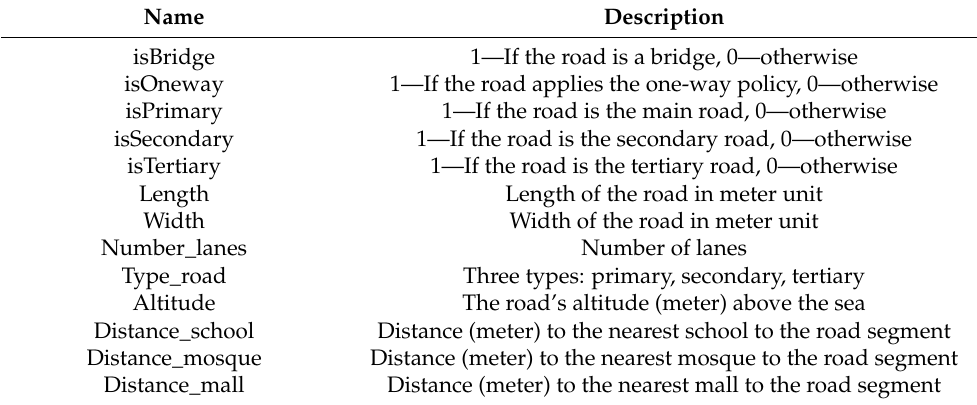
Table 4. Characteristics of the road